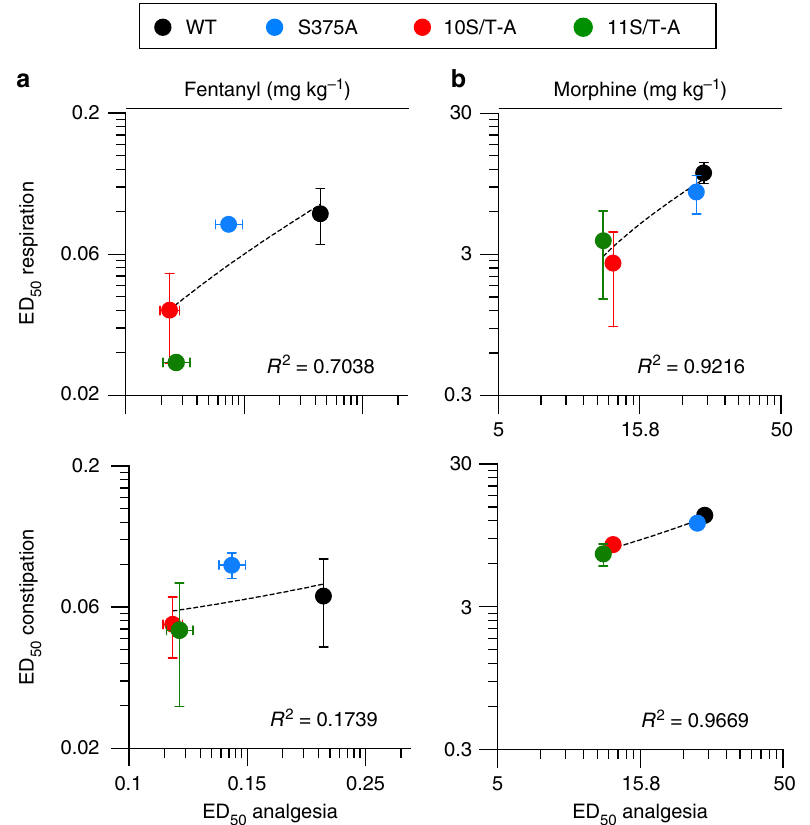
Fig. 4 Correlation of pED 50 values for analgesia and side effects across genotypes. a , b Correlation analysis of pED 50 from dose-response curves for respiratory depression or constipation plotted against the pED 50 from dose-response curves for analgesia after a , fentanyl and b , morphine treatment. Data are the means ± s.e.m.; Pearson correlation for analysis of R